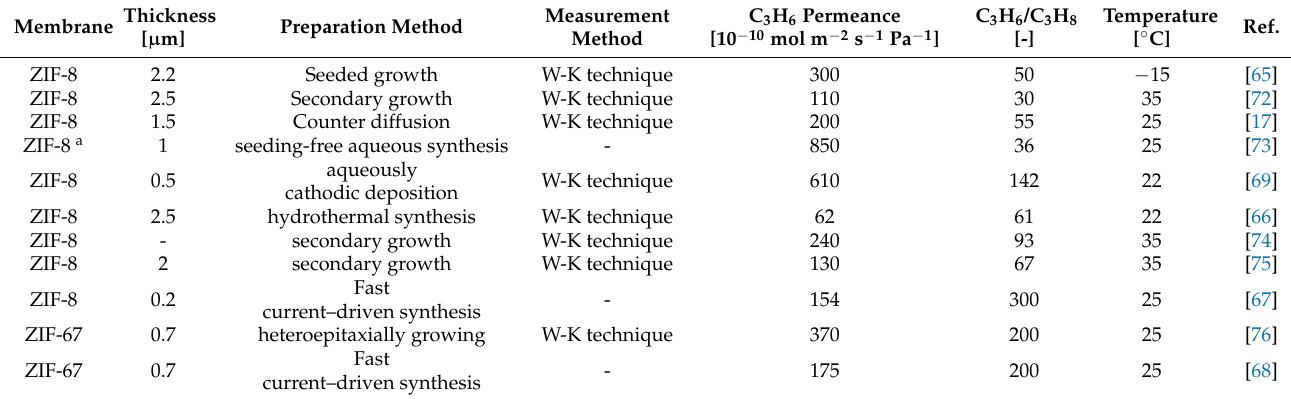
Table 7. Separation performances of C 3 H 6 /C 3 H 8 for zeolitic imidazolate framework (ZIF) membranes. Thickness Membrane Preparation Method [ µ m]